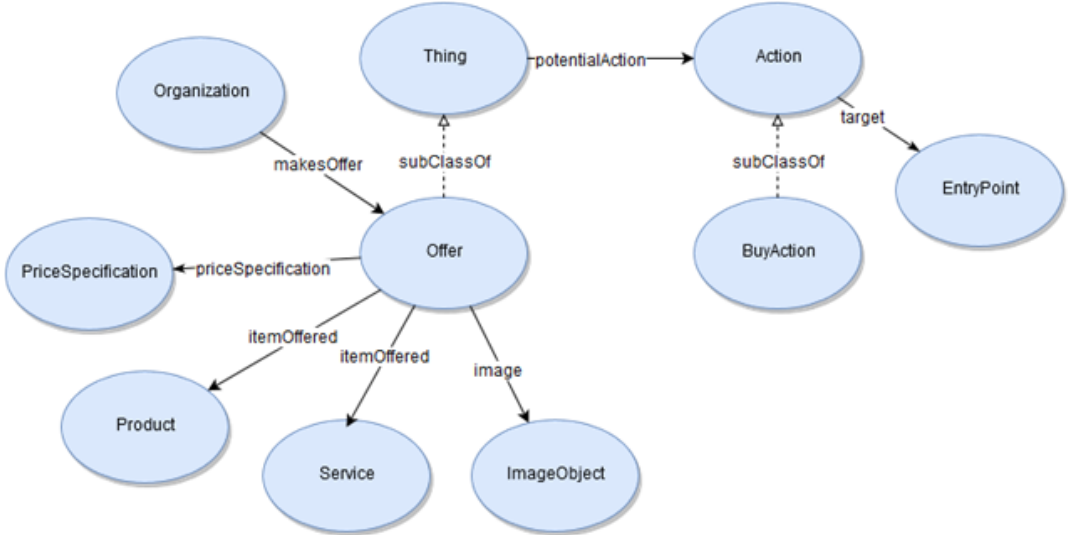
Figure 2. Visualisation of the TourPack schema.org model of a touristic service